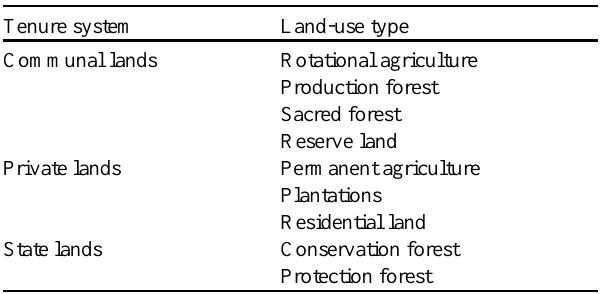
Table 1. Tenure systems for the main land-use types Tenure system